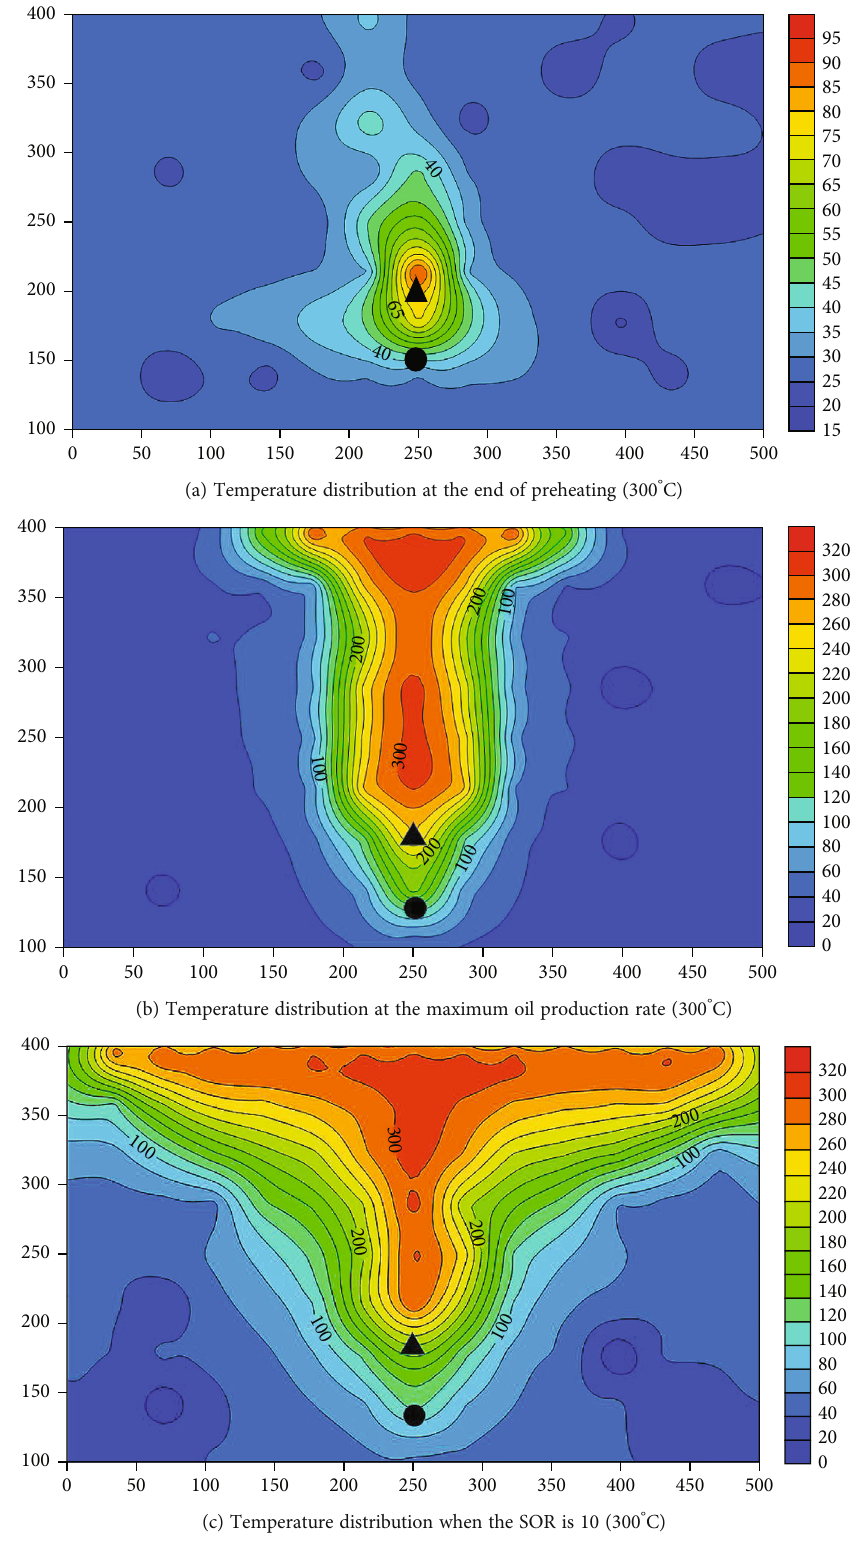
Figure 14: Temperature distribution in di ff erent periods (300 °